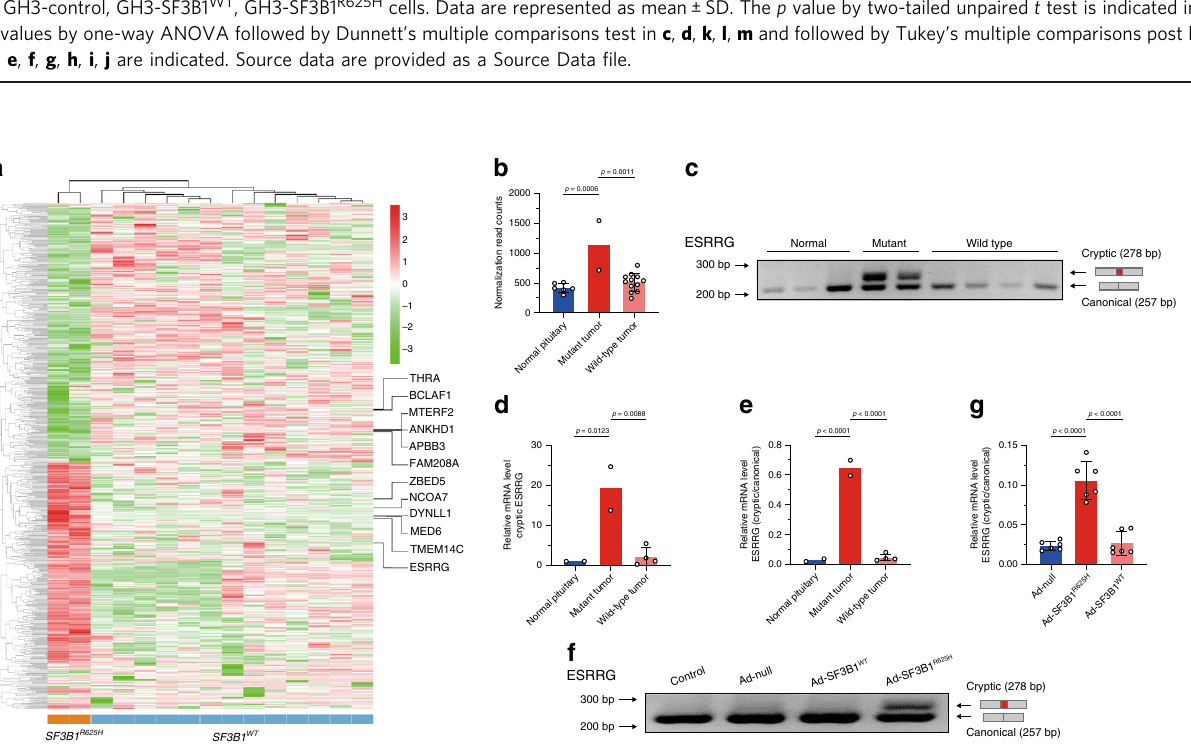
Fig. 2 Downstream effects of the SF3B1 mutation. a PRL secretion in SF3B1 wild type and SF3B1 mutant primary human prolactinomas cells. b Representative western blot for SF3B1 expression levels in primary human prolactinoma cells transfected with control or speci fi c SF3B1 siRNA. β -actin was used as internal control. c Suppression of the PRL secretion in primary human prolactinoma cells after the SF3B1 knockdown using SF3B1 siRNA. d PRL secretion in primary human prolactinoma cells infected with Ad-null, Ad-SF3B1 WT and Ad-SF3B1 R625H are shown, respectively. e Focus formation was assessed in GH3 cells infected with Ad-null, Ad-SF3B1 WT , and Ad-SF3B1 R625H at the indicated MOI. f Results of CCK-8 cell proliferation assay showing in GH3 cells infected with Ad-null, Ad-SF3B1 WT , and Ad-SF3B1 R625H at the indicated MOI. g Annexin V/PI staining and fl ow cytometry showed the percentages of apoptosis of the GH3 cells infected with Ad-null, Ad-SF3B1 WT , and Ad-SF3B1 R625H . h Focus formations were assessed in MMQ cells infected with Ad-null, Ad-SF3B1 WT , and Ad-SF3B1 R625H at the indicated MOI. i Results of CCK-8 cell proliferation assay showing in MMQ cells infected with Ad-null, Ad-SF3B1 WT , and Ad-SF3B1 R625H at the indicated MOI. j Annexin V/PI staining and fl ow cytometry showed the percentages of apoptosis of the MMQ cells infected with Ad-null, Ad-SF3B1 WT , and Ad-SF3B1 R625H . c – i n = 9 per group. k Focus formations were assessed in stable GH3-control, GH3- SF3B1 WT , GH3-SF3B1 R625H cells ( n = 6 for GH3-control and n = 3 for two other cells). l Results of CCK-8 cell proliferation assay showing in stable GH3- control, GH3-SF3B1 WT , GH3-SF3B1 R625H cells ( n = 5 per group). m Annexin V/PI staining and fl ow cytometry showed the percentages of apoptosis of stable GH3-control, GH3-SF3B1 WT , GH3-SF3B1 R625H cells. Data are represented as mean ± SD. The p value by two-tailed unpaired t test is indicated in a .